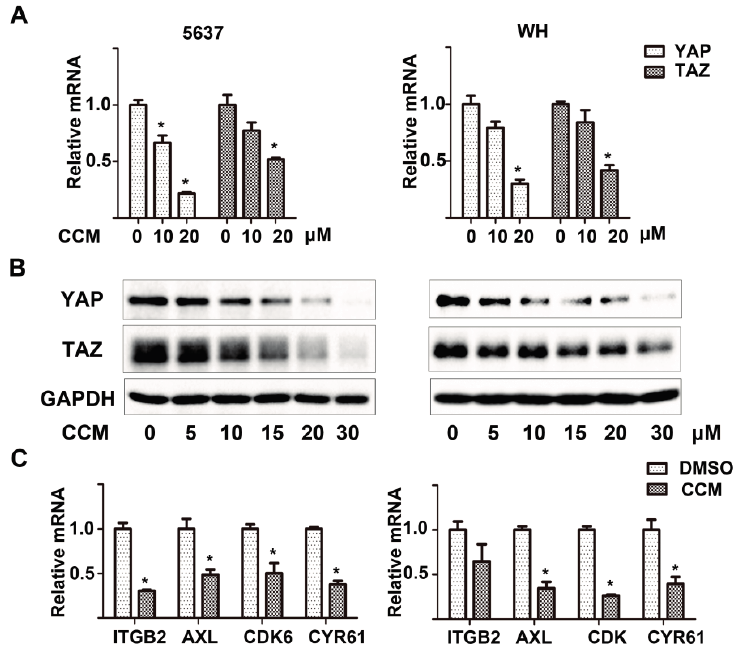
5637 ( left ) and WH ( right ) cells treated with 0, 10 or 20 μ M curcumin for 12 h as determined by real-time qPCR; ( B ) After treatment with curcumin for 12 h, YAP and TAZ protein levels were determined by western blot analysis in the two cells; ( C ) The mRNA level of YAP/TAZ downstream genes in 5637 and WH cells after treatment with 20 μ M curcumin for 24 h, as detected by real-time qPCR. Results were presented as the mean ± SD from three independent experiments. * p <